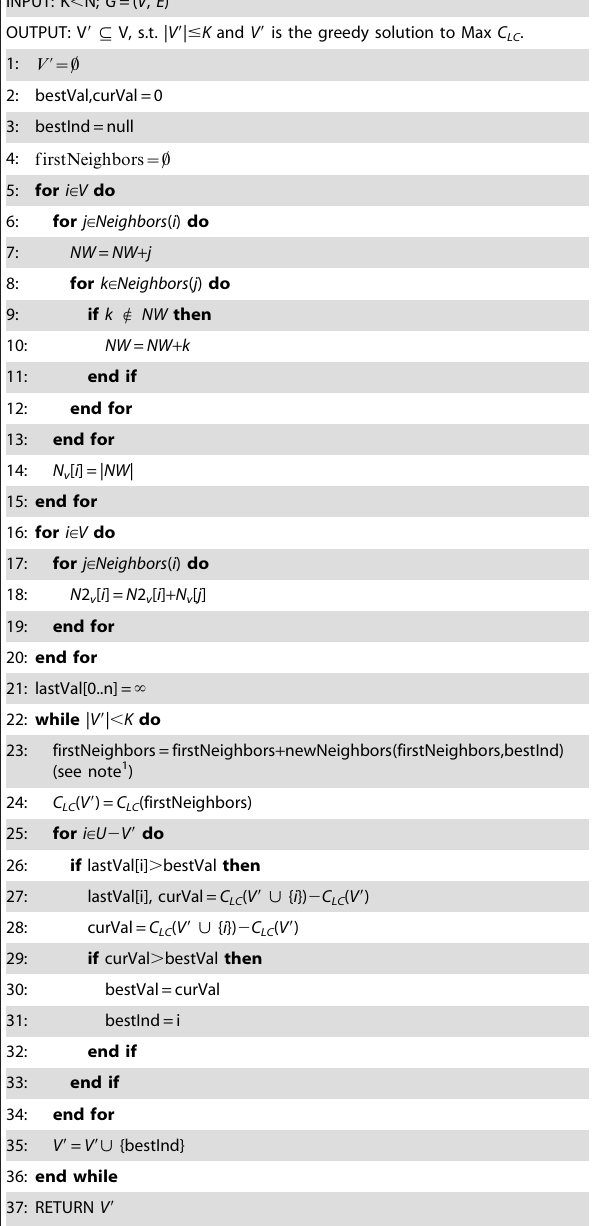
Table 2. Algorithm: GREEDY- C LC 2.